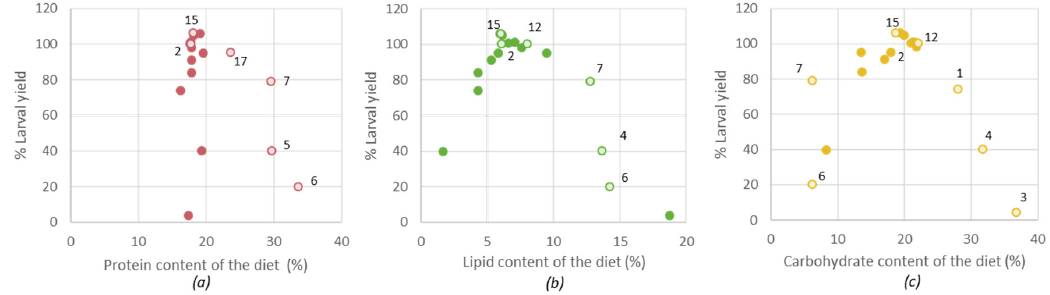
Figure 4. The relation between the dietary nutrient component and the larval yield for ( a ) the protein content, ( b ) the lipid content, ( c ) the carbohydrate content. Hollow bullets were indicated by their diet number. Diet 2 = reference diet.